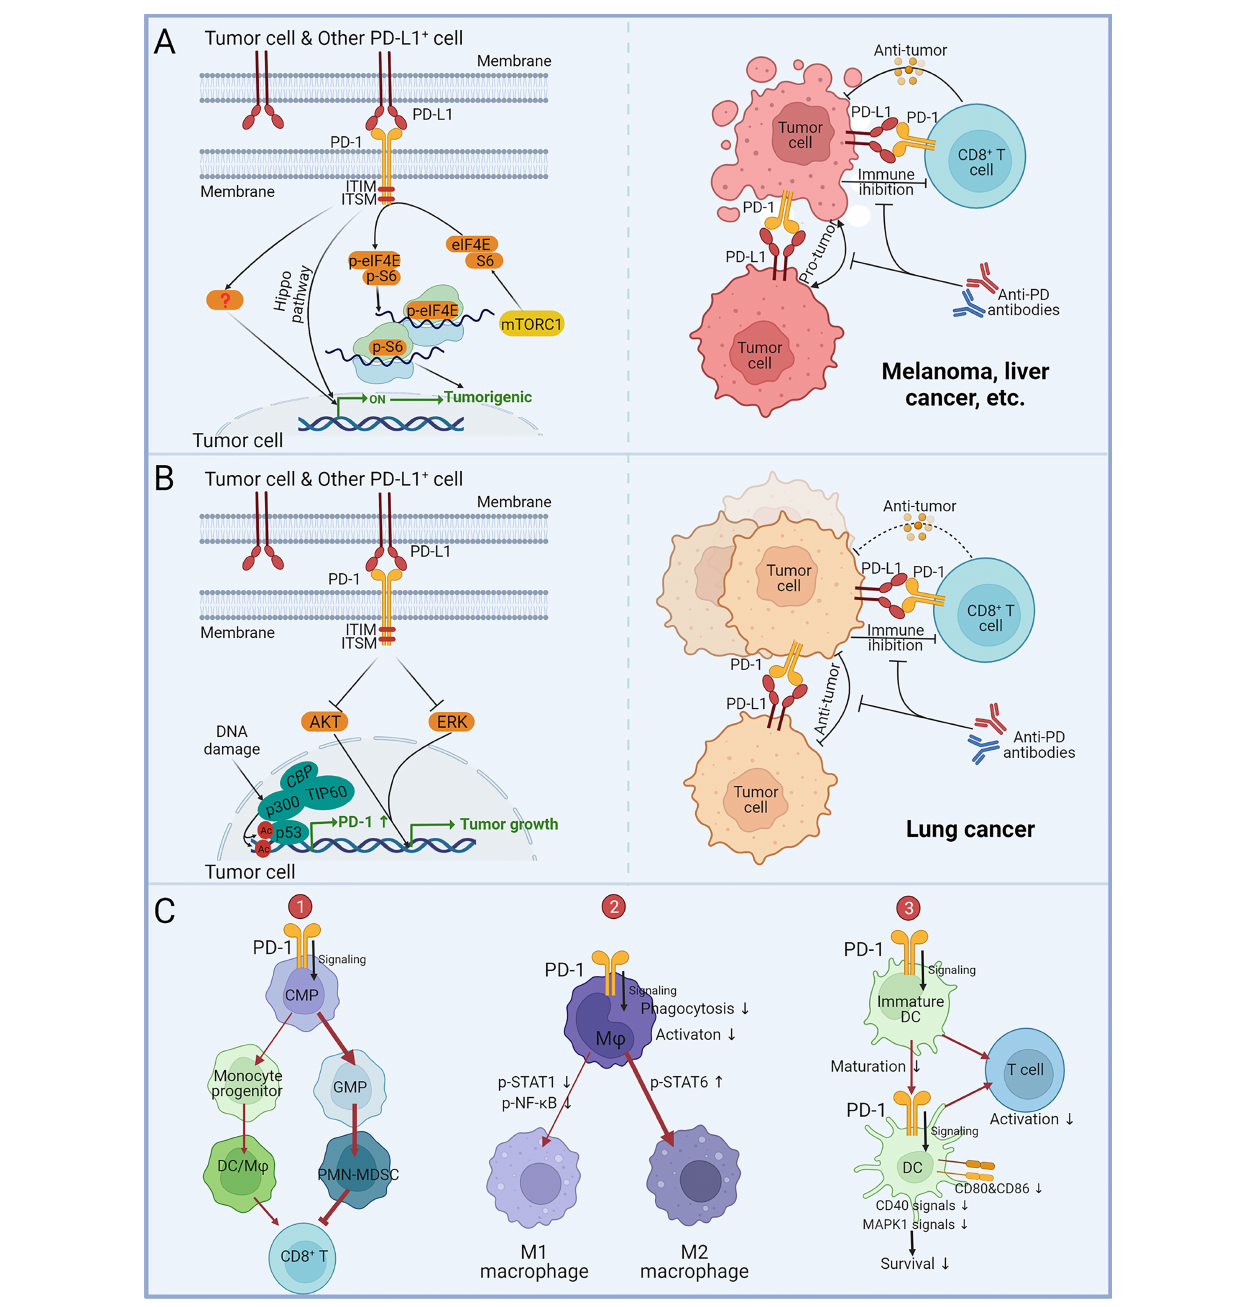
FIGURE 2 | Impact of tumor and myeloid cell-intrinsic PD-1 on tumor progression. (A) The effect of tumor cell-intrinsic PD-1 on melanoma, liver cancer, and other malignancies. PD-L1 expressed by tumor cells or other cells acts on PD-1 + tumor cells to mediate PD-1 signaling in tumor cells via ITIM and ITSM. The Hippo pathway and phosphorylation of mTOR downstream effector molecules eIF4E and S6 can enhance tumor-promoting gene transcription and protein expression. Anti-PD antibodies can block the PD-1/PD L1-mediated tumor promotion independent of adaptive immunity. (B) The role of tumor cell-intrinsic PD-1 in lung cancer. PD-L1 expressed by tumor cells or other cells acts on PD-1 + tumor cells to suppress tumor growth by dampening AKT and ERK signaling. Acetylation of p53 promotes gene transcription of PD-1. Anti-PD antibodies block PD-1/PD-L1-mediated tumor suppression, leading to hyperprogression in immunocompromised patients. (C) Effects of myeloid PD-1 on cell development, differentiation and function. (1) PD-1 expression promotes common myeloid progenitors (CMP) differentiation into granulocyte/macrophage progenitors (GMP), leading to increased MDSCs in granulocyte lineages and suppressing the activity of anti-tumor CD8 + T-cells. (2) PD-1 suppresses M1 polarization by reducing STAT1 and NF- k B phosphorylation and promoted M2 polarization by increasing STAT6 phosphorylation. (3) PD-1 suppresses DC maturation, survival and co-stimulatory molecules expression, consequently downregulating antigen-speci fi c T-cell